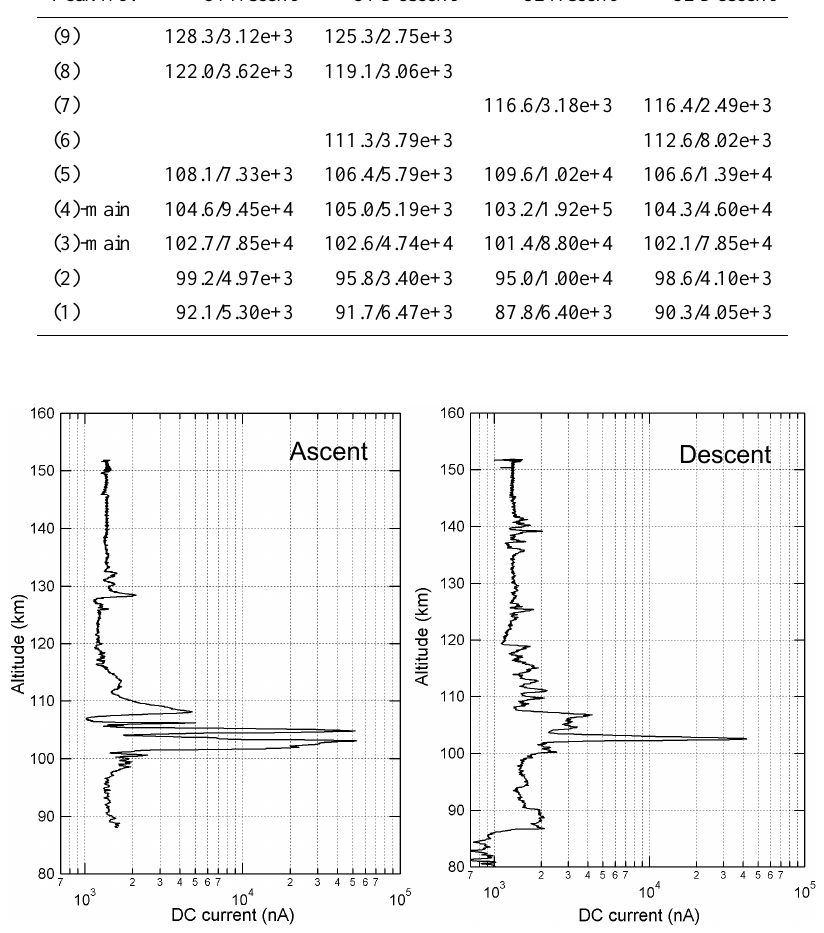
Table 1. Summary of the peak density location in the altitude profile obtained during the SEEK-2 campaign. The contents of the table represent “peak altitude (km)/peak density (/cc)”. And No. (3) and (4) are the main peaks due to the sporadic- E layer. Peak No.